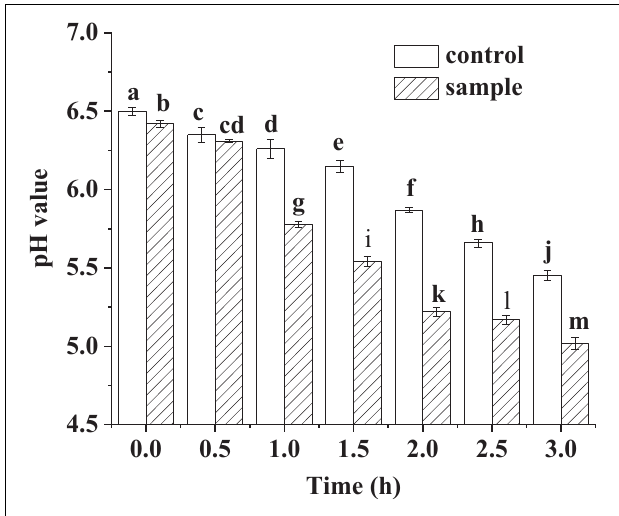
FIGURE 1 | The pH of the sausages in fermentation, in which different lowercase letters meant that the pH was significantly different ( p < 0.05).